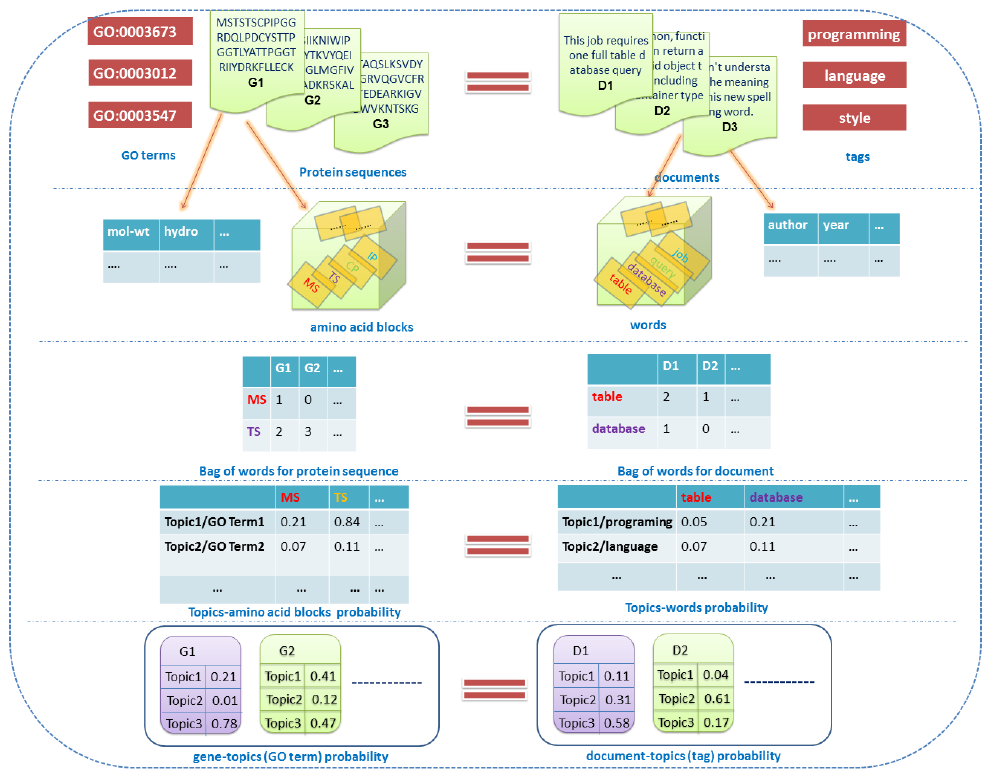
Figure 1. The relationship between protein function prediction and text topic modeling. IP, CP, TS, MS and so on, represent ‘words’, each of which is composed by two amino acid alphabets. Each GO term is started by ‘GO:’.